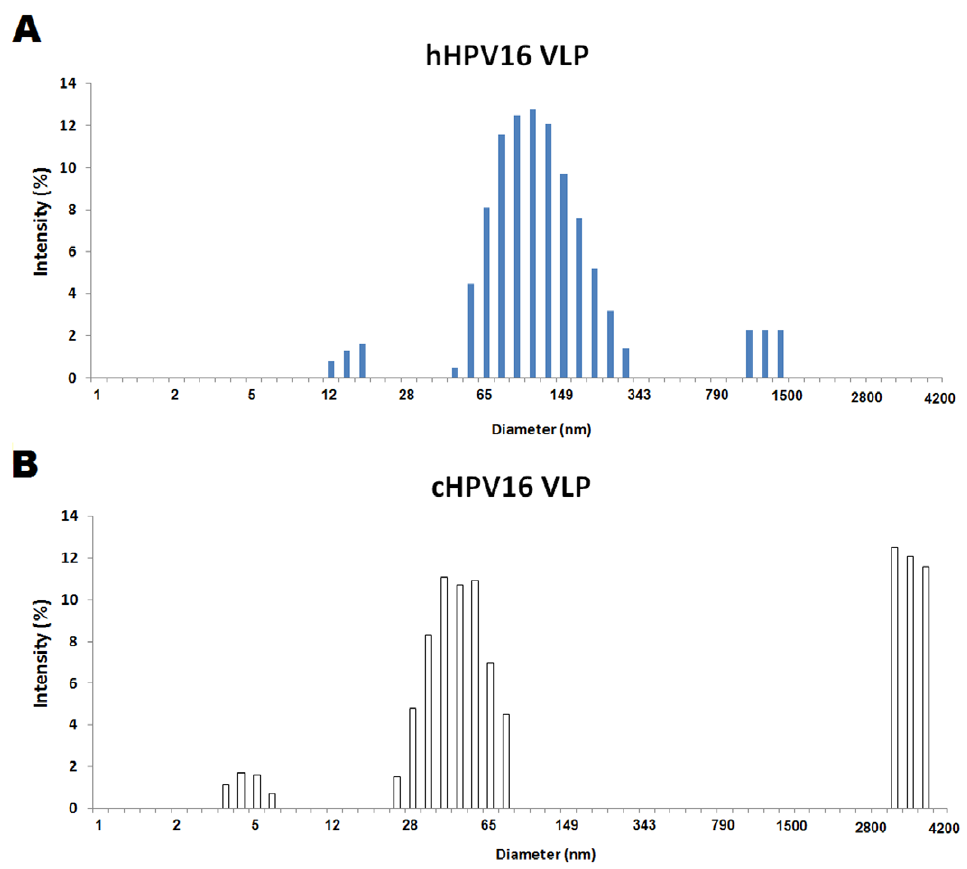
Figure 4. Particle size distributions of hHPV16 VLP and cHPV16 VLP. The HPV16 VLP populations along with their associated hydrodynamic diameters were analyzed by DLS as described in the Materials and Methods section. Each HPV16 VLP was prepared in 25 mM MOPS containing 75 mM NaCl pH 7.0 and adjusted to 40 m g/ml. Panel A and B are representatives of duplicate measurements of the hHPV16 VLP and cHPV16 VLP populations,